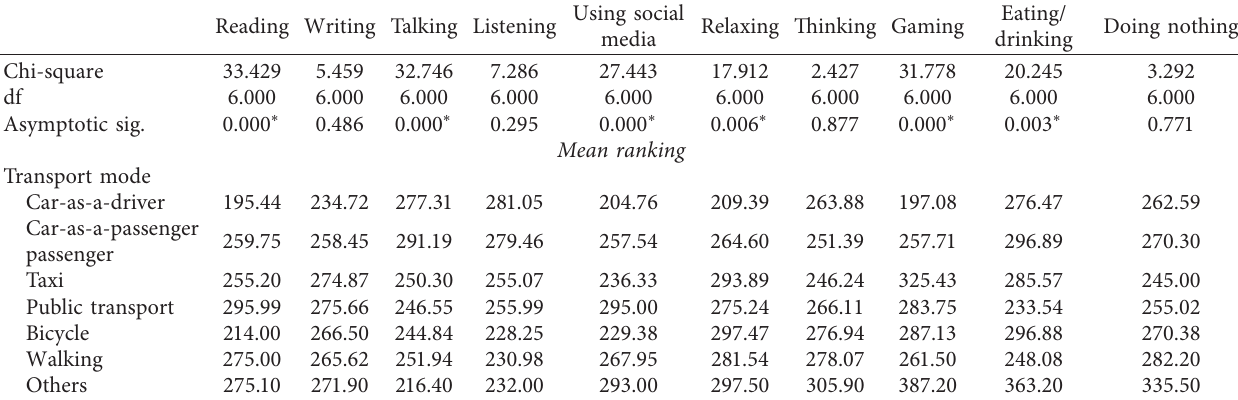
Table 13: Kruskal–Wallis test statistics and the rankings of transport mode groups.